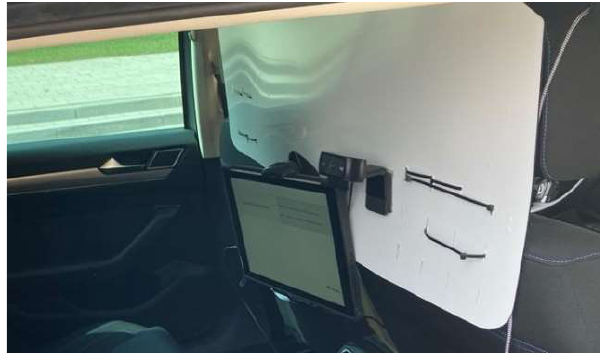
Figure 2. Interior of the vehicle with the partition that was installed to conceal the fact that the safety driver was in fact driving manually (own